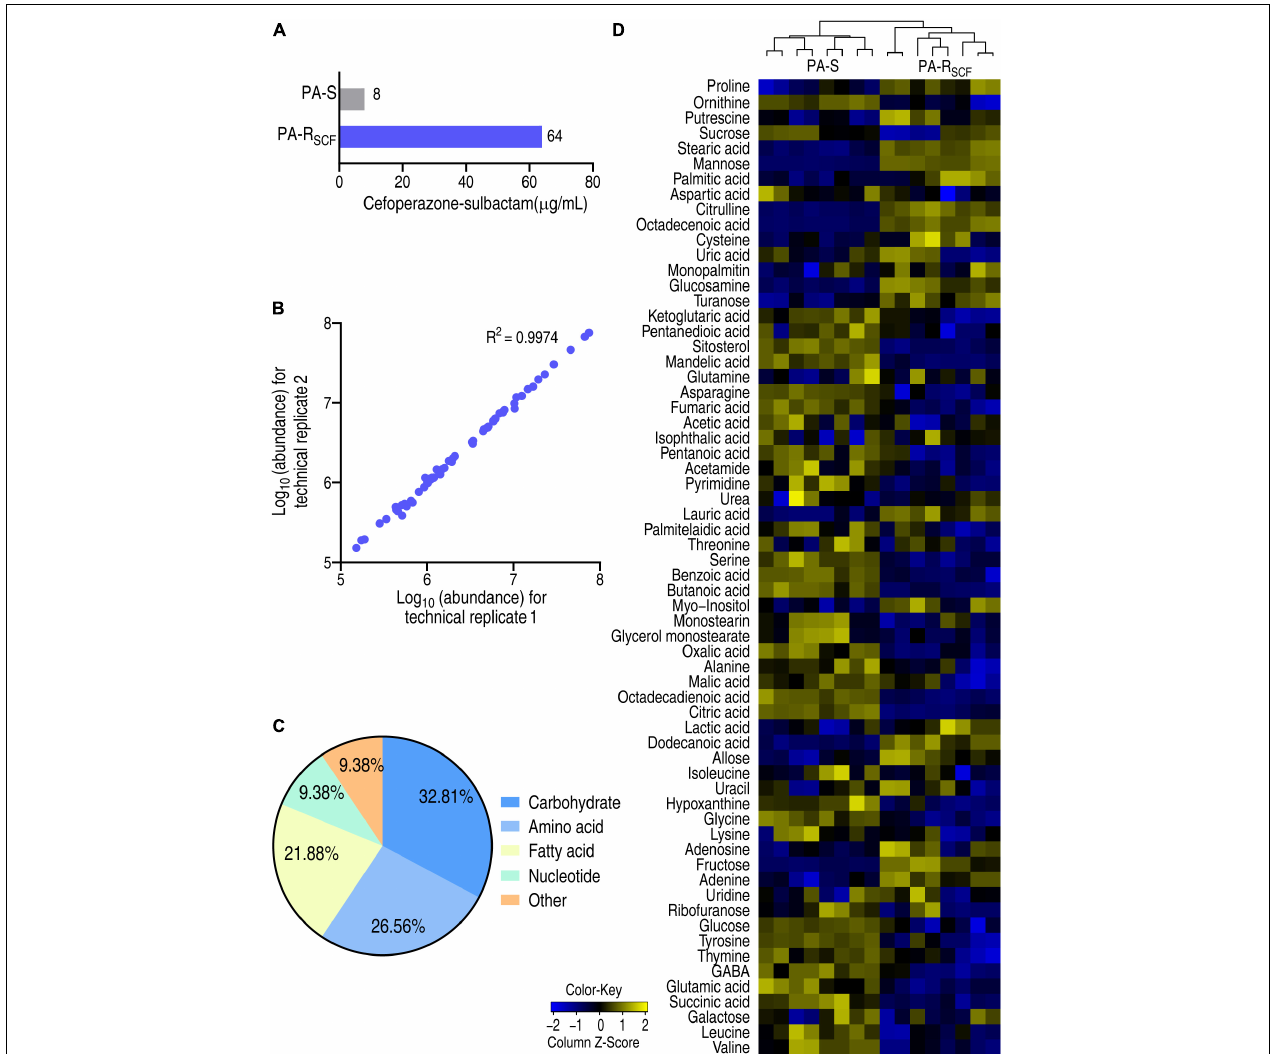
FIGURE 1 | Resistance to SCF and metabolic profile in PA-R SCF . (A) MIC of PA-S and PA-R SCF strains. (B) Abundance correlation of metabolites quantified in two technical replicates with high reproducibility. Metabolite abundance was represented in log 10 . (C) Categories of the metabolites in PA-S and PA-R SCF . (D) Heatmaps of unsupervised hierarchical clustering of differential metabolites in PA-S and PA-R SCF (row). Blue and yellow indicate lower and higher expression of the metabolites relative to the mean and standard deviation of the row metabolite level, respectively (see color scale).